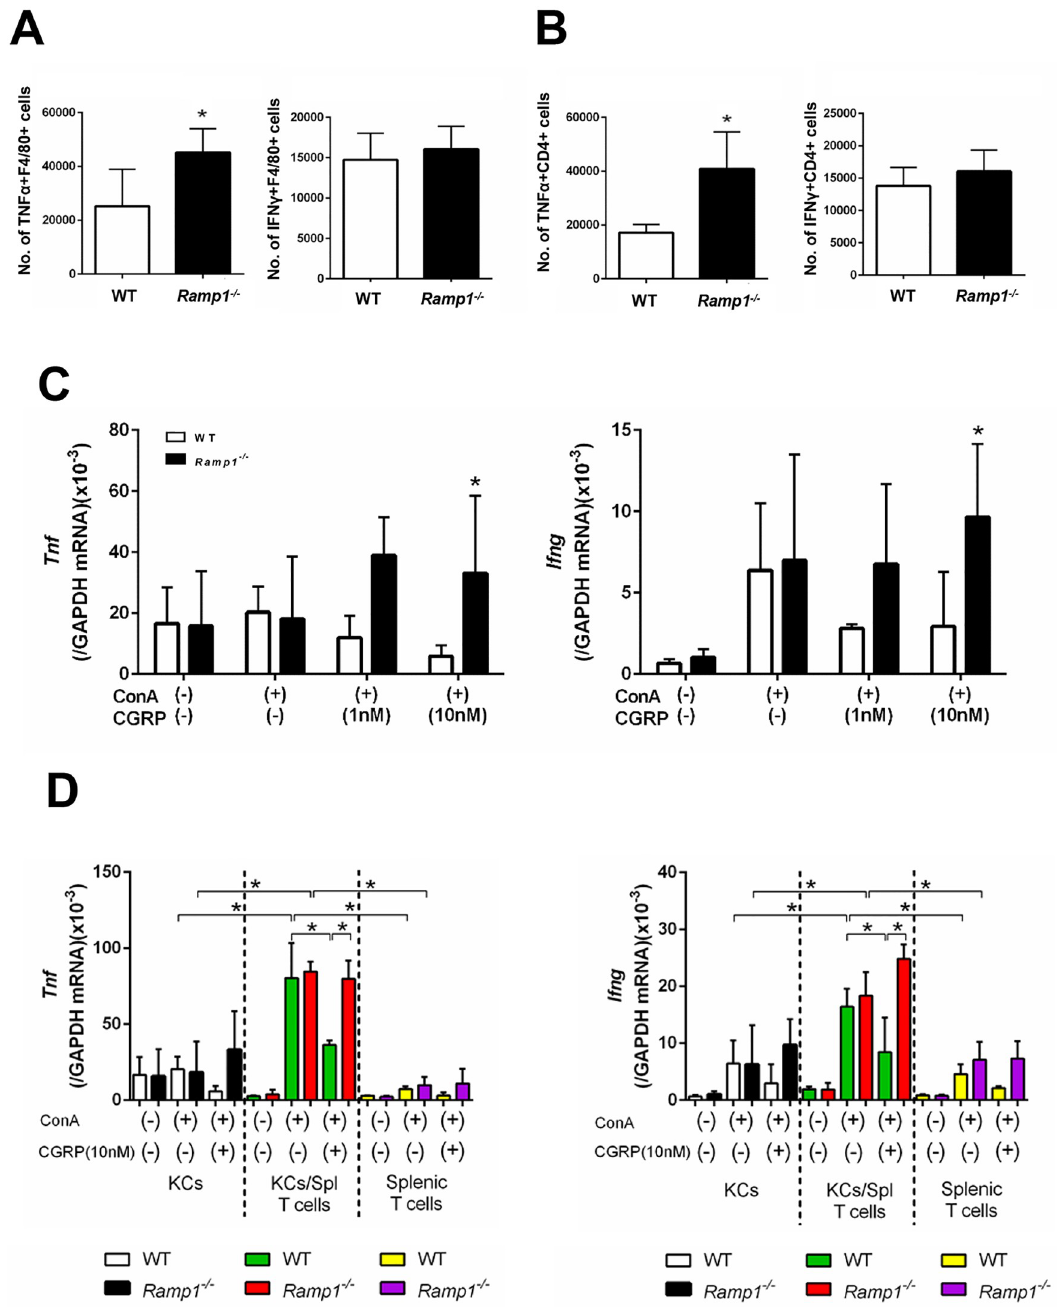
Fig 6. RAMP1 signaling regulates expression of pro-inflammatory cytokines in hepatic macrophages and splenic T cells. (A,B) The numbers of TNF α - and IFN γ -producing F4/80+ cells (A) and the numbers of TNF α - and IFN γ -producing CD4+ T cells (B) in the liver from WT and Ramp1 -/- mice at 1 h after ConA treatment. Expression of TNF α and IFN γ was analyzed by flow cytometry. Data are expressed as the mean ± SD from six mice per group. � p < 0.05 vs . WT mice. (C) Amounts of Tnf and Ifng mRNA in KCs isolated from WT and Ramp1 -/- mice. Isolated KCs were stimulated with CGRP (1 and 10 nM) with or without ConA for 3 h. KCs were isolated by magnetic-activated cell sorting (MACS). Data are expressed as the mean ± SD from 4–5 mice per group. � p < 0.05 vs . WT mice. (D) Amounts of Tnf and Ifng mRNA in KCs and/or splenic CD4+ T cells isolated from WT and Ramp1 -/- mice. KCs co-cultured with splenic CD4+ T cells were stimulated with CGRP with or without ConA for 1 h. Data are expressed as the mean ± SD from 4–5 mice per group. � p <